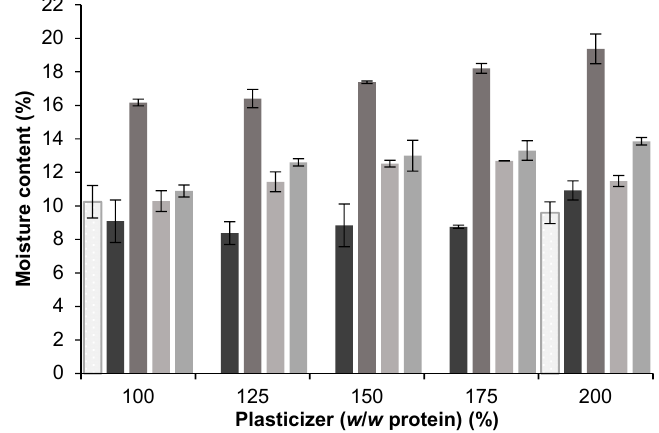
Figure 1. Equilibrium moisture content of the cast films after three weeks at 23 °C and 50 % RH with different plasticizer concentrations (100–200 % ( w / w protein)) in the following order: EG, PG, glycerol, sorbitol and PEG 400. Error bars show standard deviation.